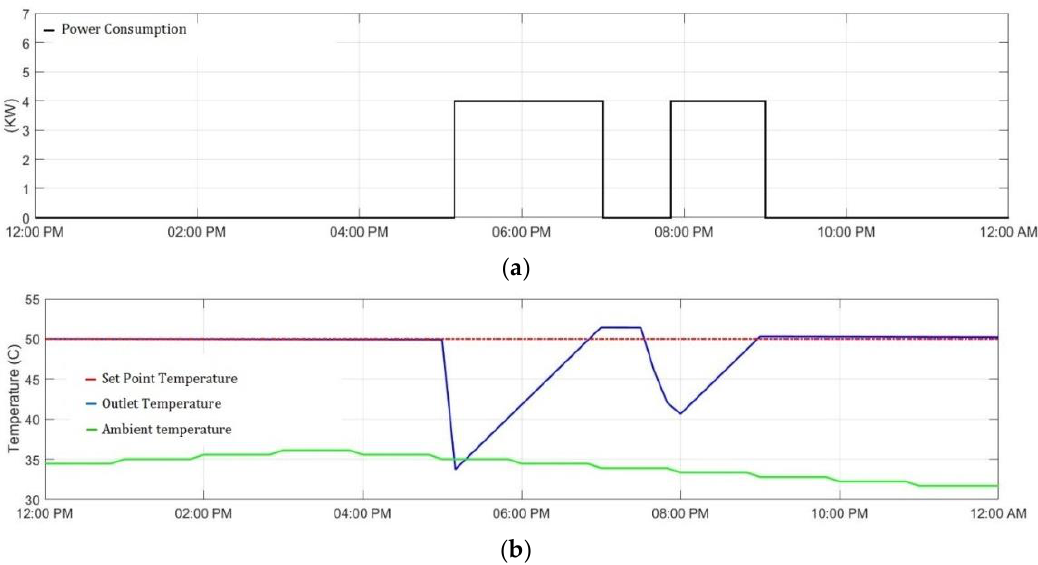
Figure 2. Simulation results of water heater (WH) model. ( a ) WH power consumption and ( b ) WH outlet temperature versus set point.